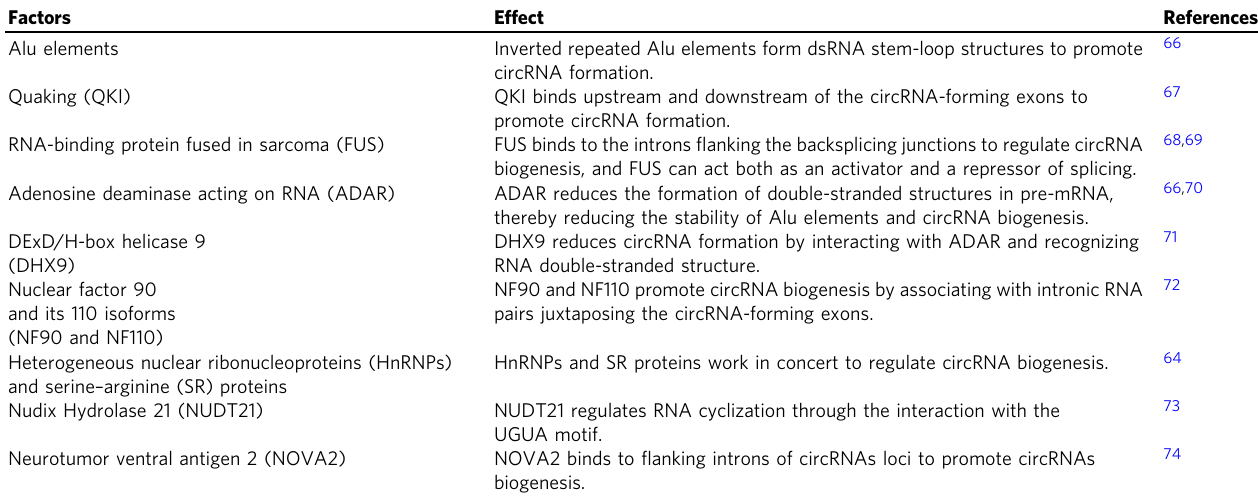
Table 1 Factors in fl uencing circRNA